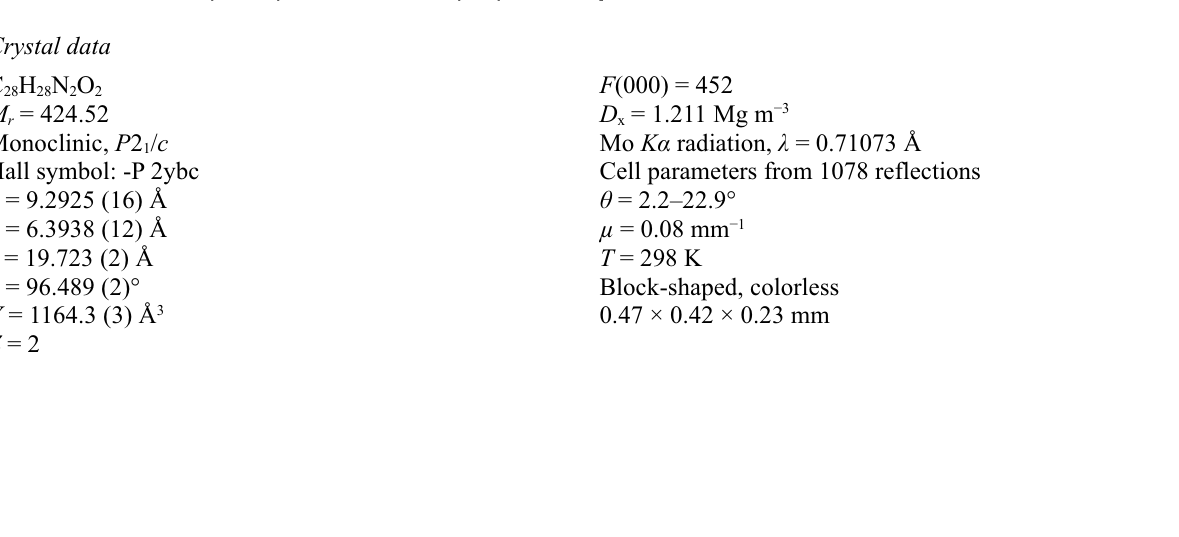
Crystal structure of (I) showing the formation of π – π interactions (Inter-molecular plane-to-plane distance, 2.986 (2) Å). 1,1 ′